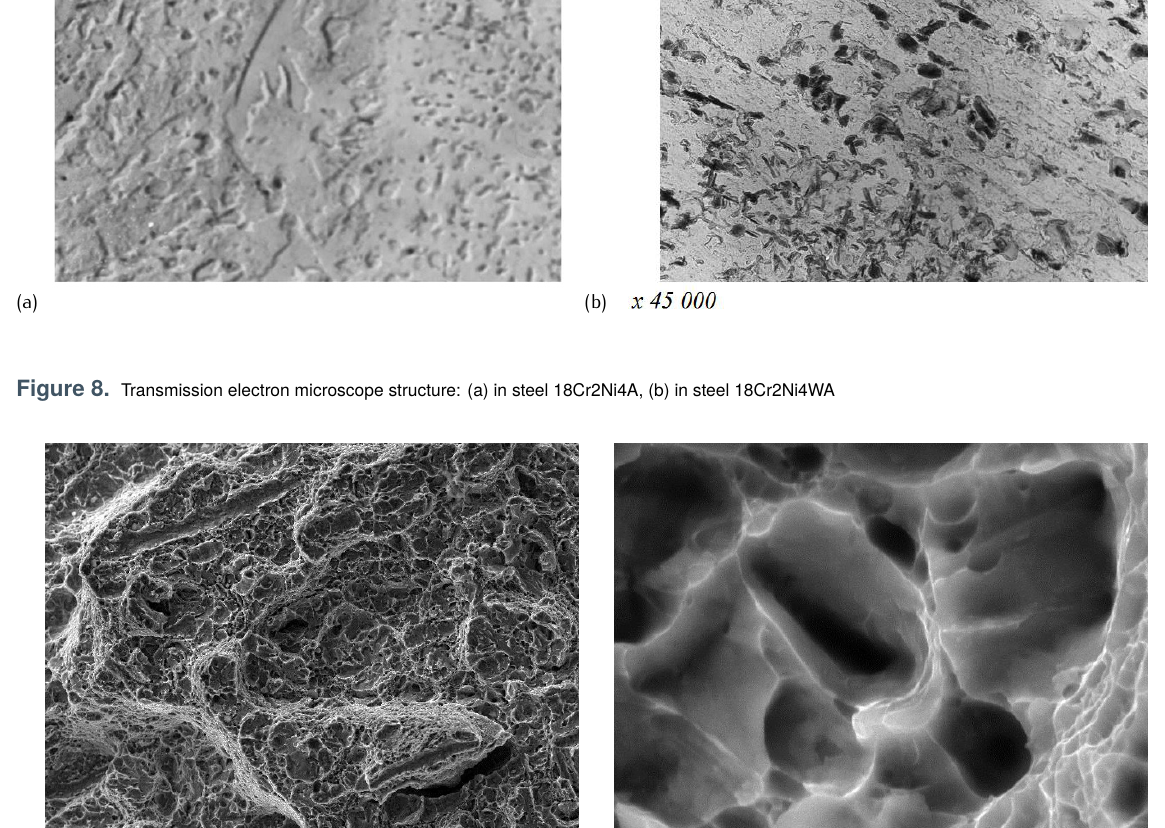
velocity from austenization temperature was with smaller energy of rupture than lath